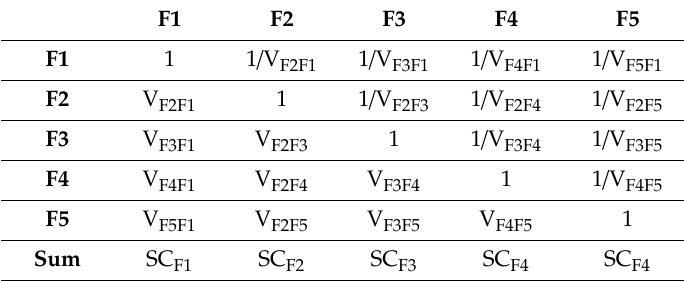
Table 3. Pairwise comparisons of the groups.